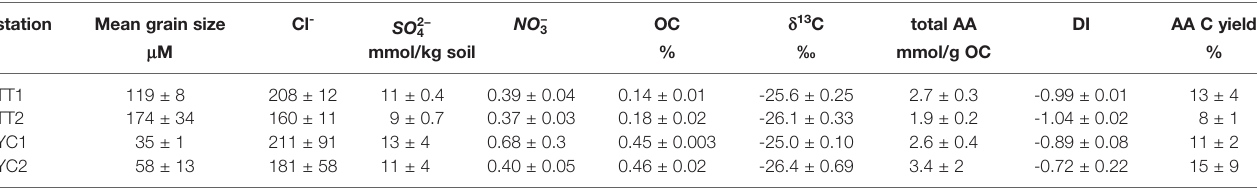
TABLE 2 | Environmental parameters and organic carbon results for the tidal fl ats organic matter in this study.